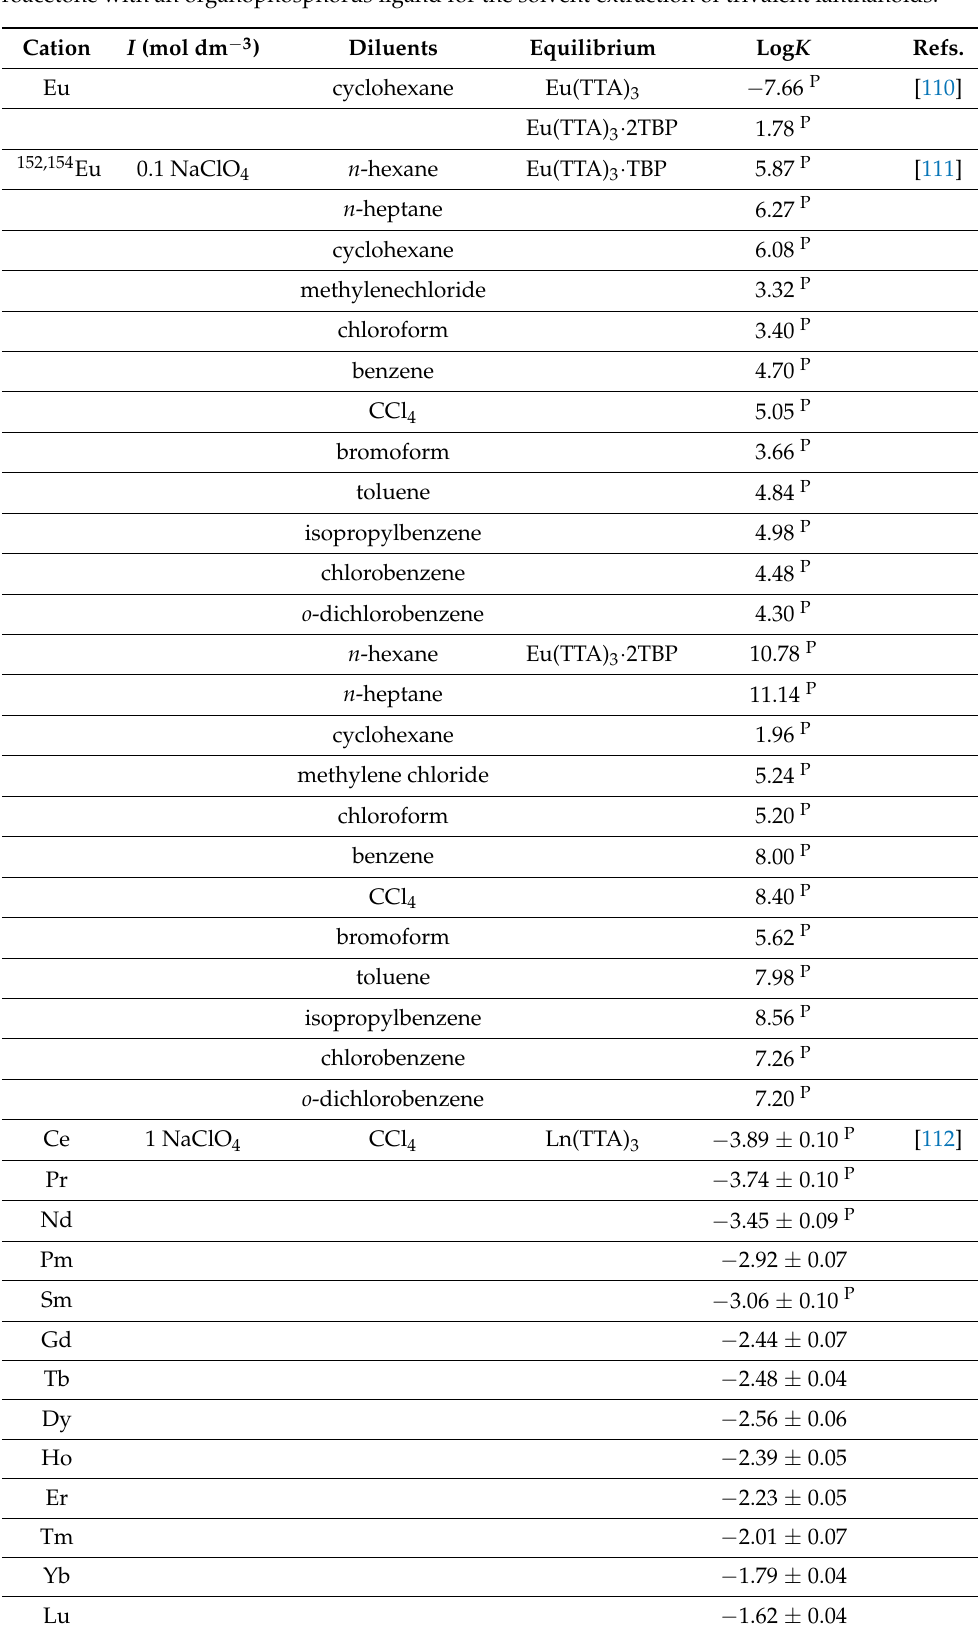
Table 2. Recommended and provisional (noted as “P”) data for synergistic systems of thenoyltrifluo- roacetone with an organophosphorus ligand for the solvent extraction of trivalent